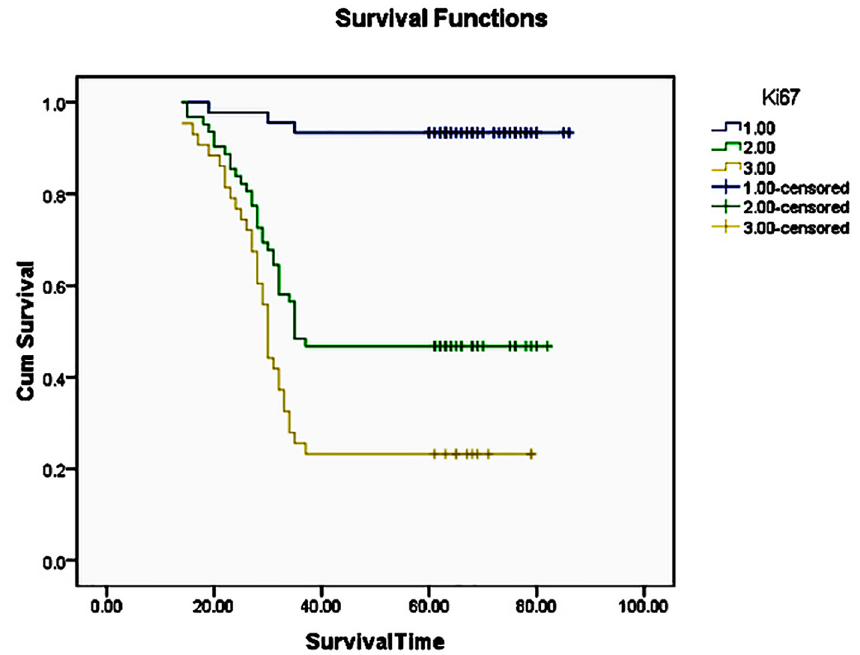
Figure 4- The Kaplan-Meier curve for 5 years disease free survival rate for oral squamous cell carcinoma with respect to 1: Low Ki67 labeling index (≤45), 2: Moderate Ki67 labeling index (46 to 60) and 3: High Ki67 labeling index